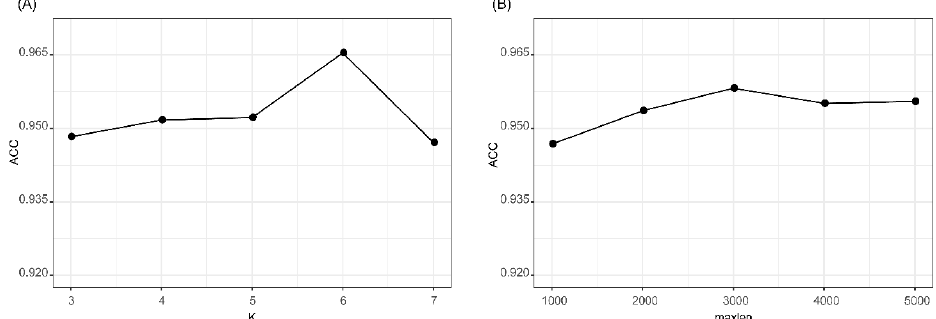
Figure 2. Results of k -mer_DNN and One-hot_CNN with di ff erent parameters. ( A ) Accuracy of k -mer_DNN with di ff erent k values. ( B ) Accuracy of One-hot_CNN with di ff erent maxlen values. k -mer_DNN, the DNN model with the k -mer feature as input. One-hot_CNN, the CNN model with one-hot encoding as